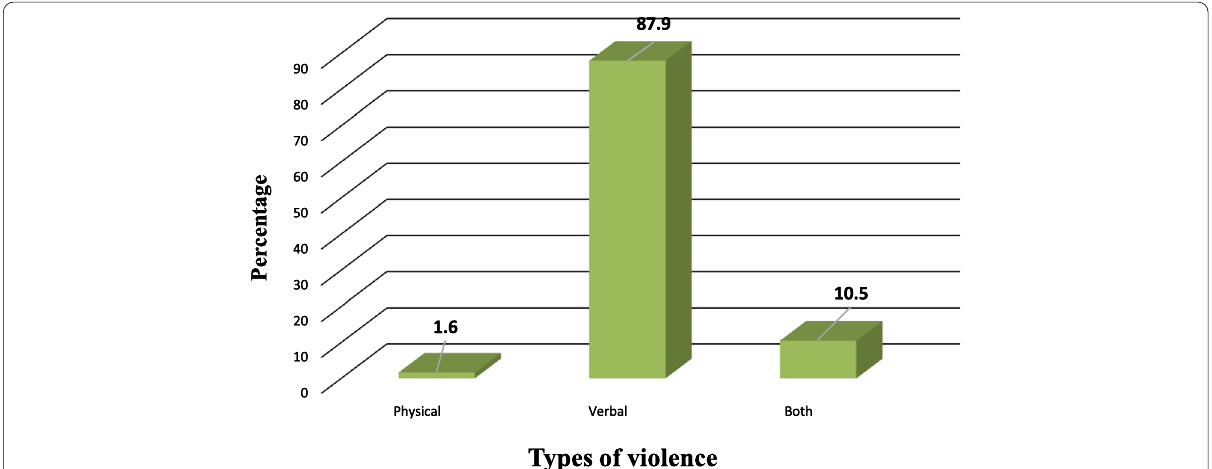
Fig. 2 The pattern of workplace violence among the exposed healthcare workers in our study in the context of the COVID‑19 pandemic in Egypt ( n =